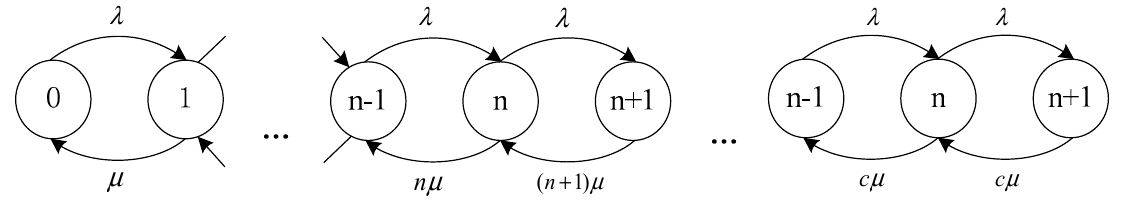
Figure A2. M/M/c queuing model state FigureA2. M/M/c queuing model state transition. FigureA2. M/M/c queuing model state transition.